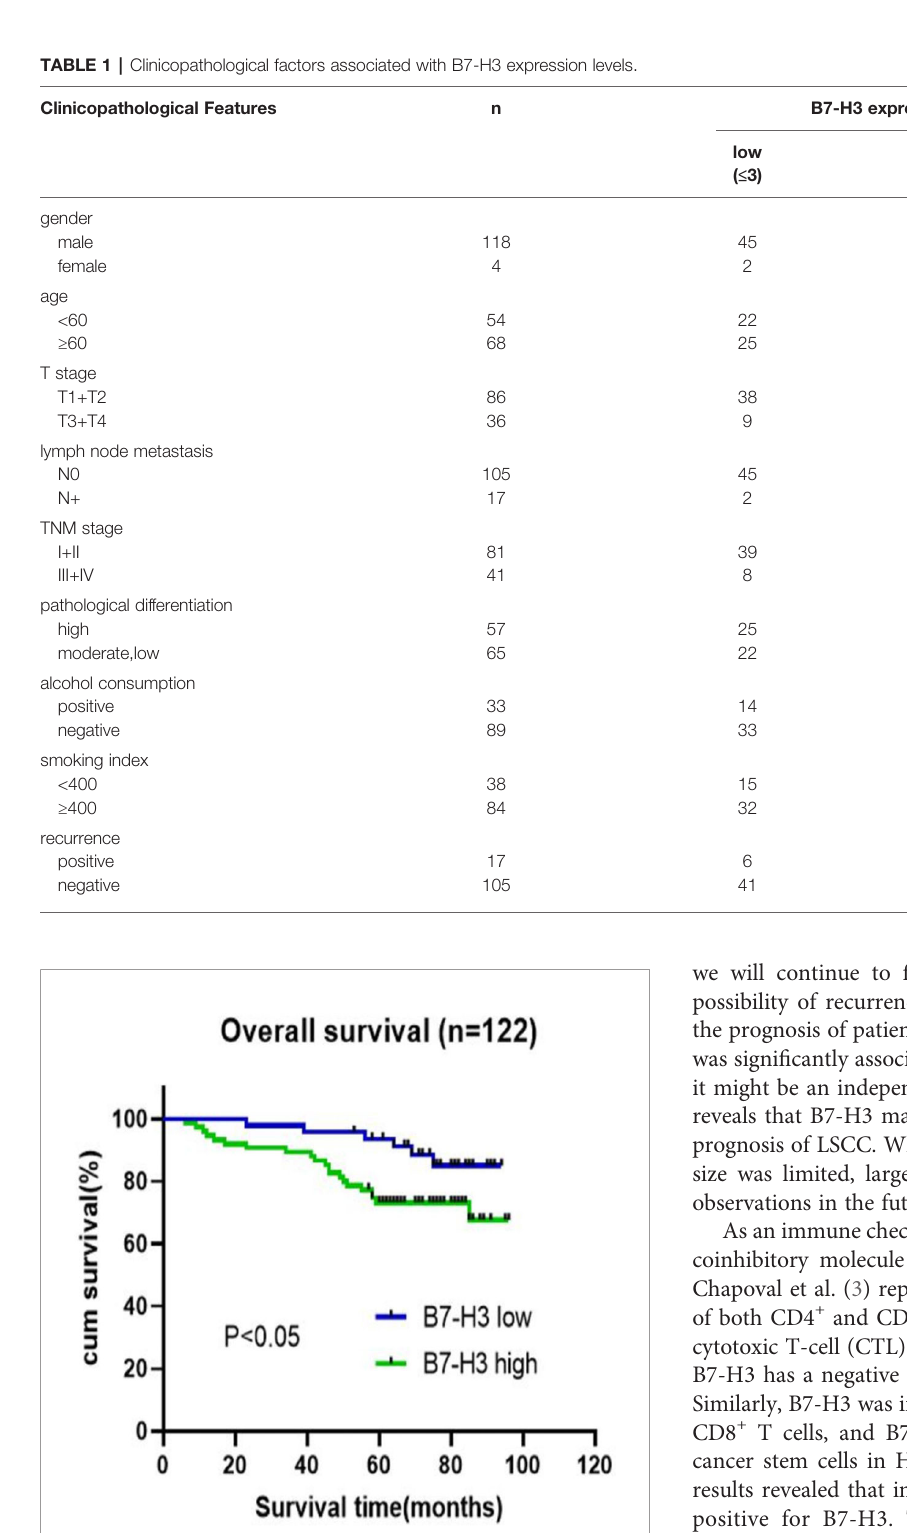
FIGURE 4 | Survival analysis of correlation of overexpression of B7-H3 and overall survival in LSCC patients. The overall survival rate was calculated with Kaplan-Meier method and compared with log-rank test